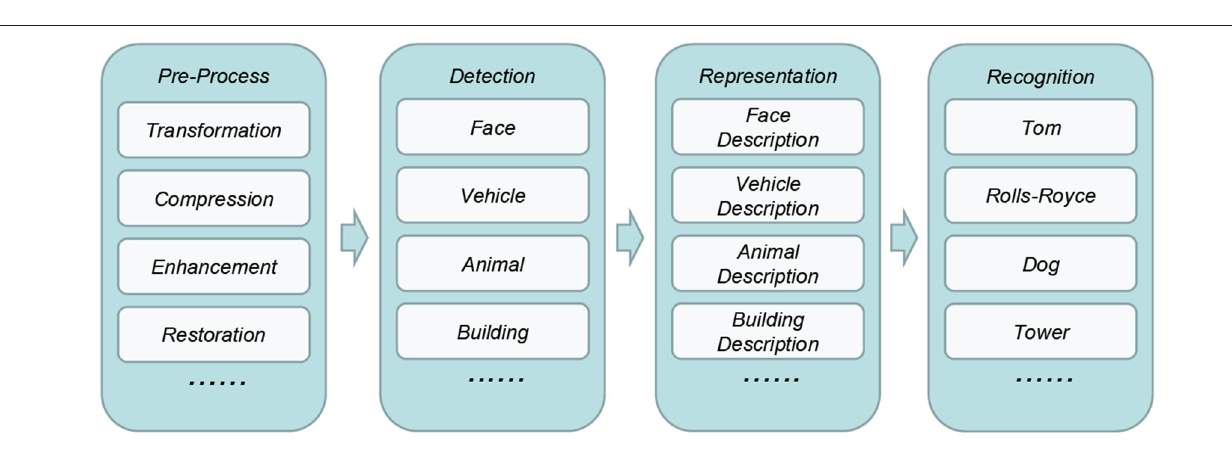
FIGURE 2 | Workflow of image